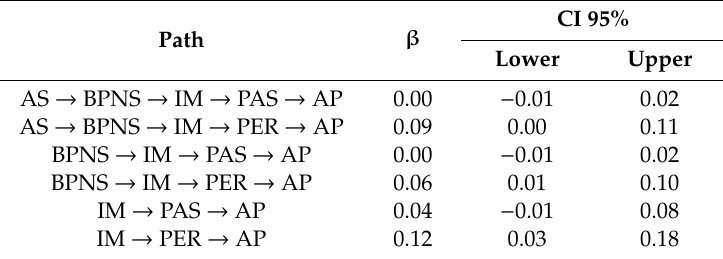
Table 3. Specific indirect